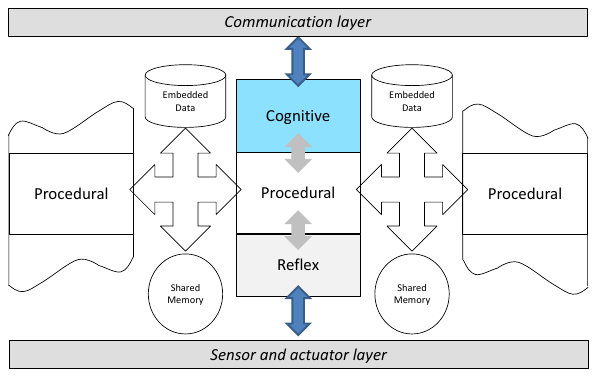
Figure 3: Multi-level subsystem organization and subsystem